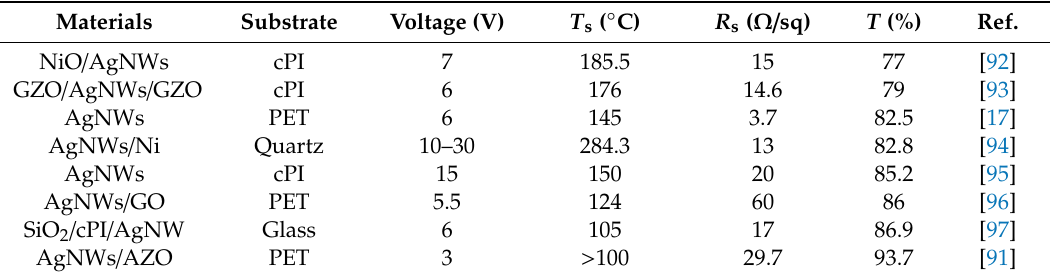
Table 4. Performance of AgNW-based Transparent film heater